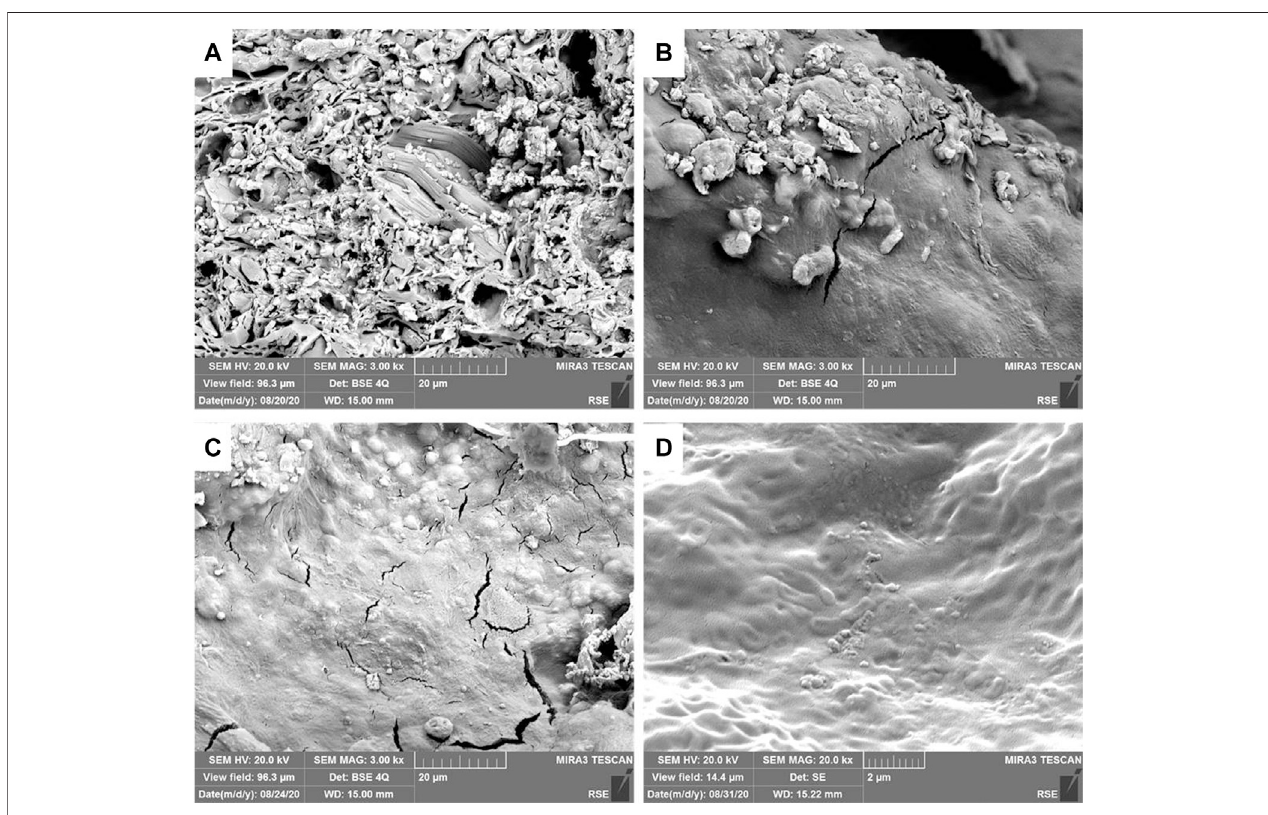
FIGURE 10 | SEM Micrographs of transversal section of composite after the operation in the MFCs. (A) terracotta (0%); (B) composite B30%; (C) composite A30%; (D) composite A30% at higher magnitude, most evidently showing bacteria shapes.